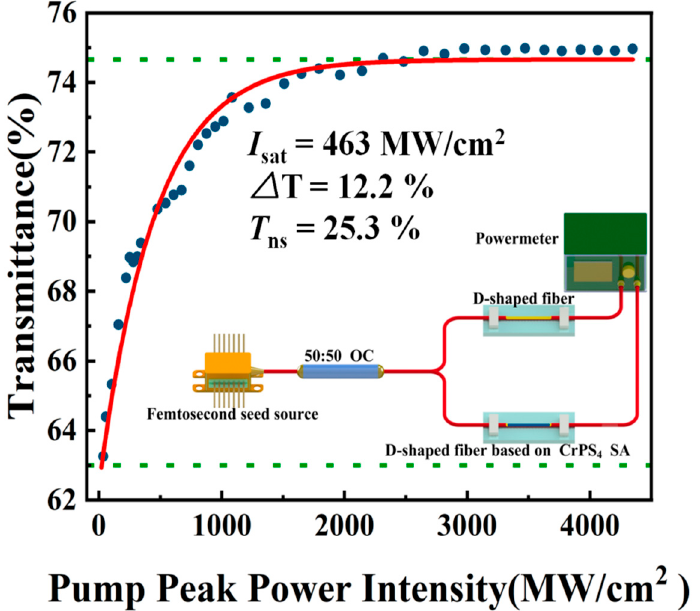
Figure 4. P-scan measurement system diagram and the corresponding nonlinear saturable absorption curve of CrPS 4.